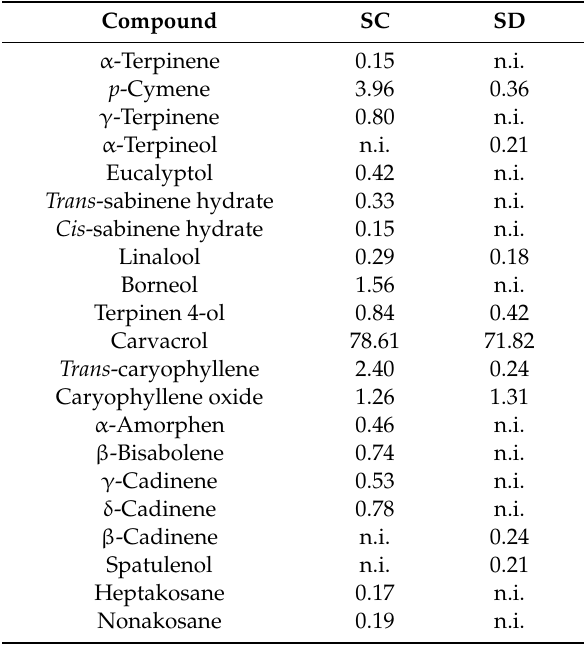
Table 2. GC / MS analysis of extract obtained by Sc-CO 2 ((SC) extract) and essential oil isolated from spray-dried (SD) extract (relative percentage; %) [32,33]. Compound SC SD α -Terpinene 0.15